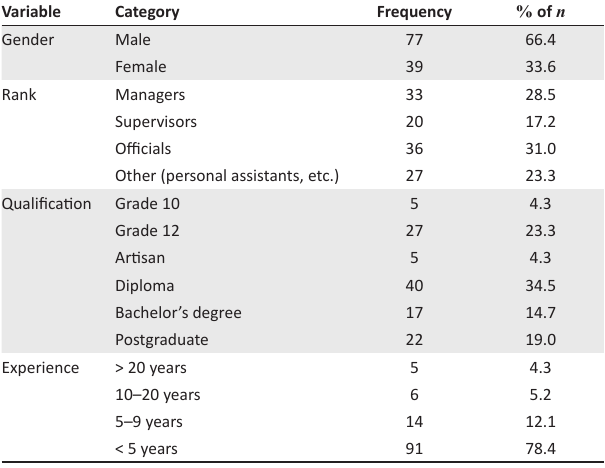
TABLE 1: Composition of the research sample ( n =